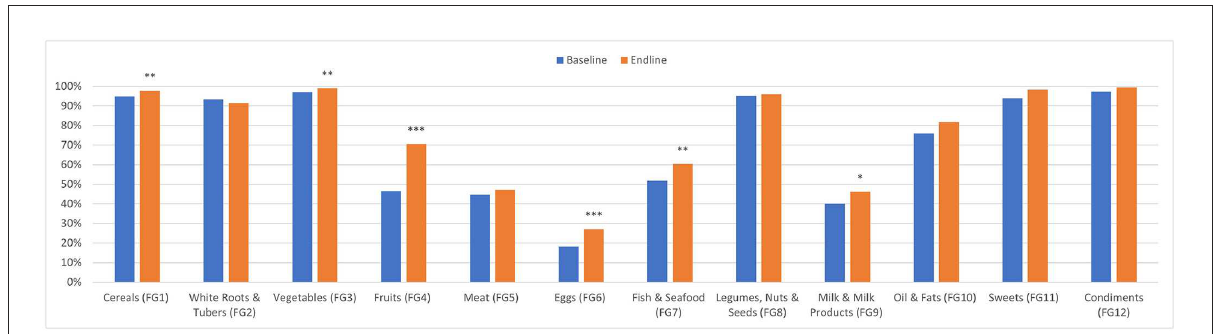
FIGURE2 Distribution of food group consumption in the March (baseline) and December (endline) survey in 2021. * p < 0.10, ** p < 0.05, *** p <